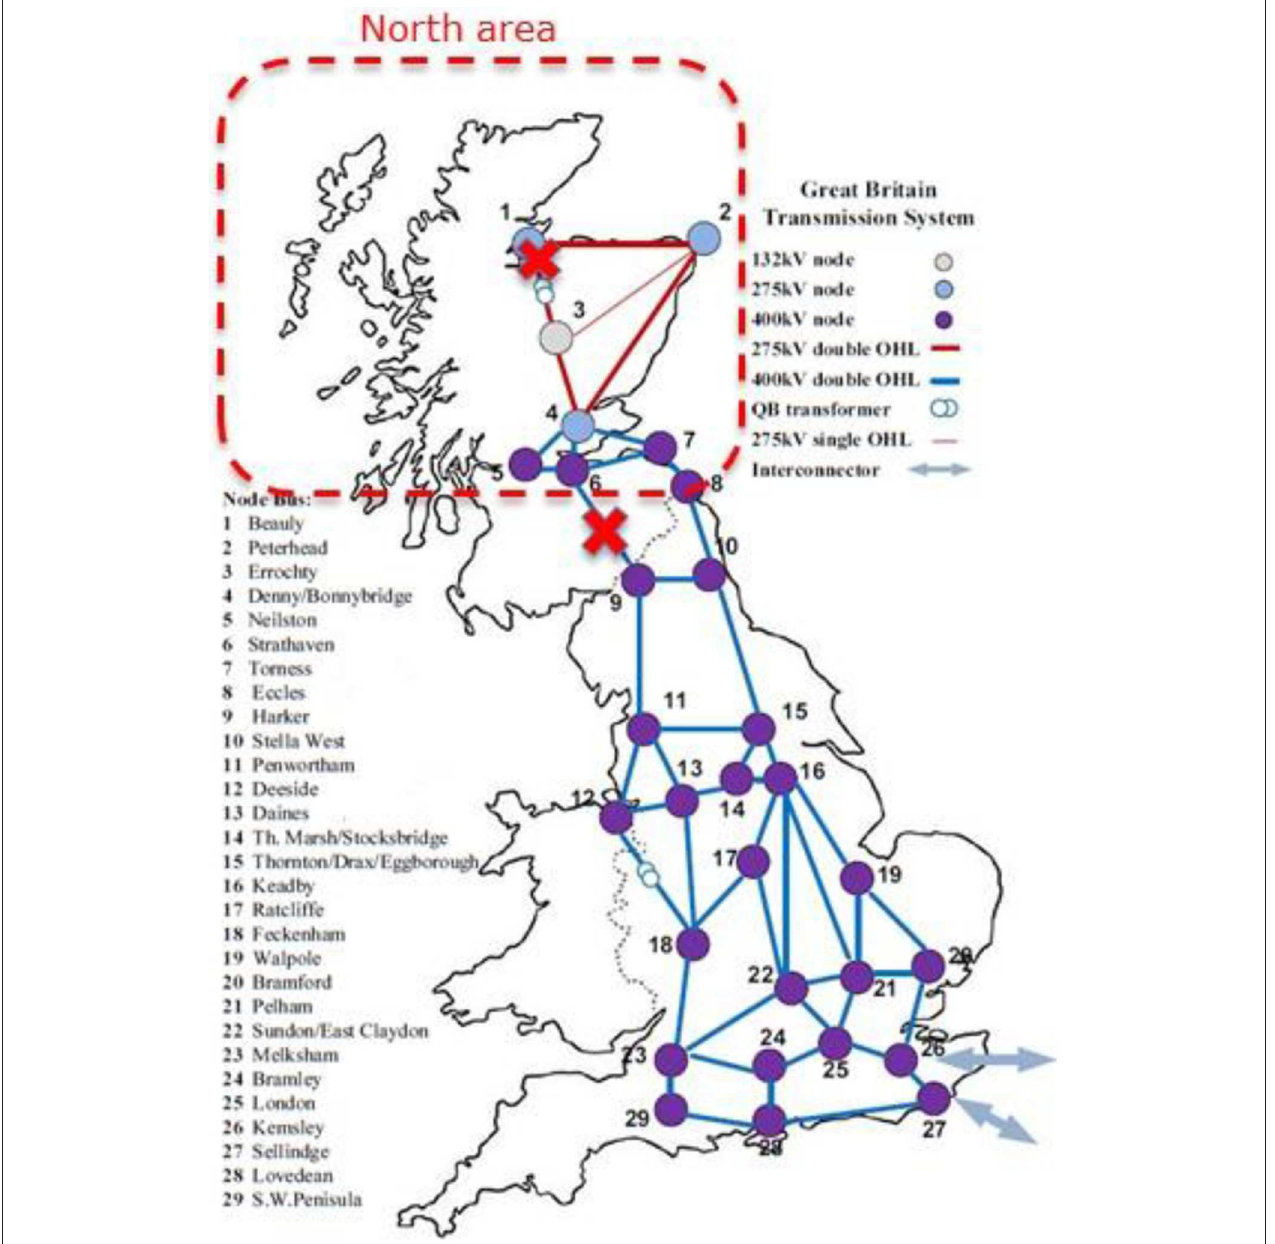
FIGURE 10 | GB test